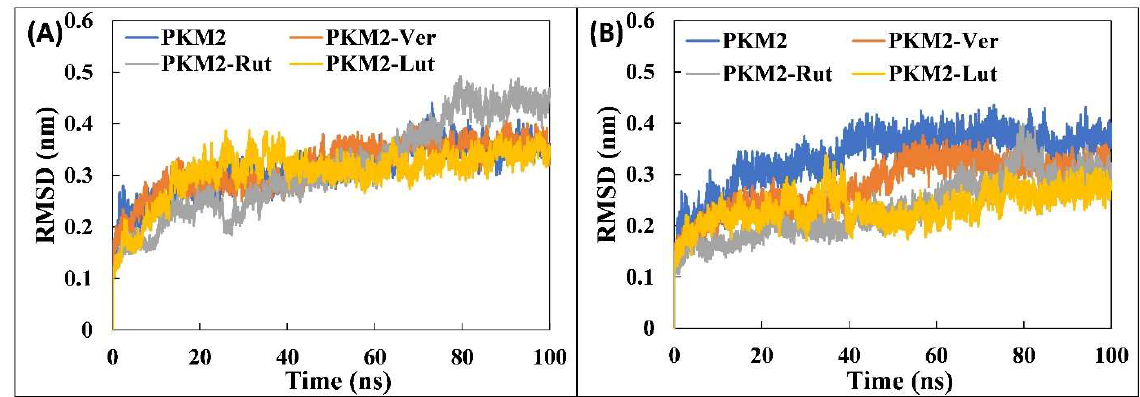
Figure 2. ( A ) Root mean square deviation (RMSD) of the backbone atoms of PKM2 and its complexes with Ver, Rut, and Lut over 100 ns of simulation. ( B ) RMSD of the binding pocket residues of PKM2 in the absence and presence of ligands (Ver, Rut, and Lut). The data presented are averages of three independent simulations.